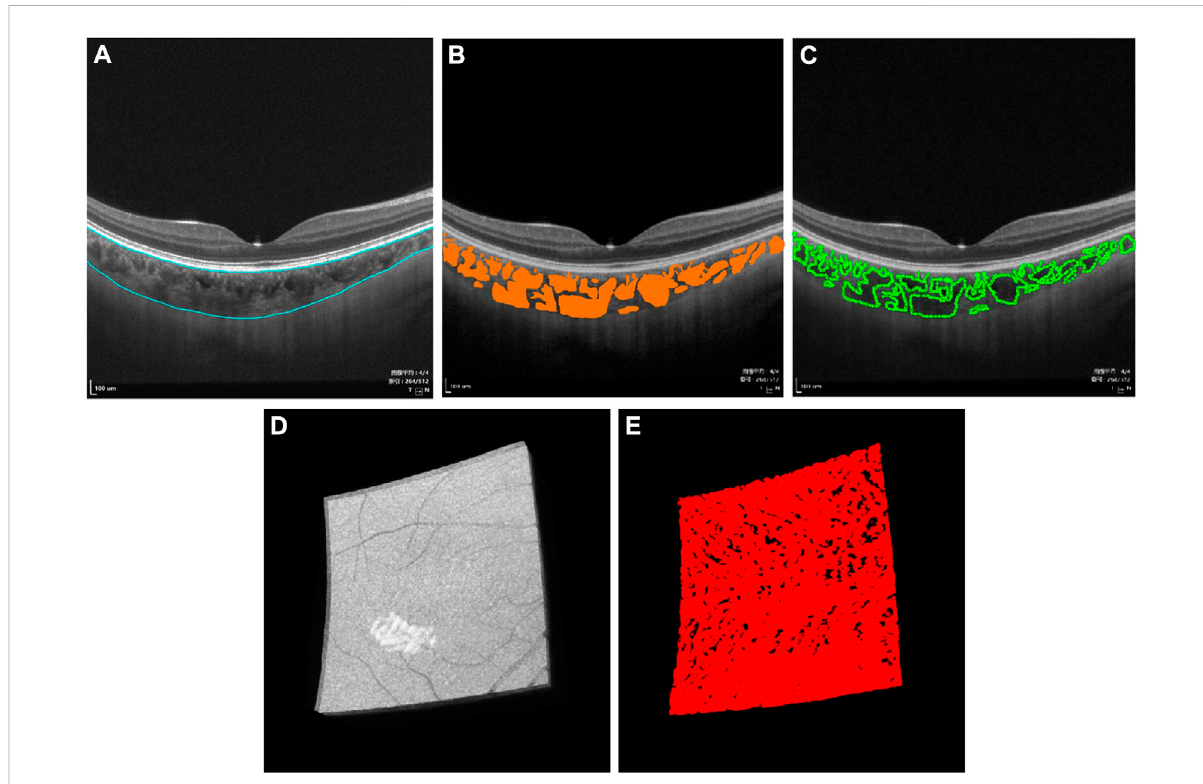
FIGURE 1 Three-dimensional (3D) representation and quanti fi cation of choroidal vascularity index (CVI). (A) Raw B-scan image of SS-OCTA with the superior and inferior boundary of the choroid (blue curve). (B) Choroidal thickness and choroidal lumen (orange area) were identi fi ed by deep learning. (C) Choroidal lumen was double-blind manually marked on the obtained B-scan images, which used the LabelMe tool (v3.11.2, https:// github.com/wkentaro/labelme) by an experienced ophthalmologist (H.L.), demonstrating excellent coherence with (B) . (D) Raw 3D choroid image in the macular region of 6 mm × 6 mm acquired by SS-OCTA. (E) 3D CVI image generated from (D) by deep